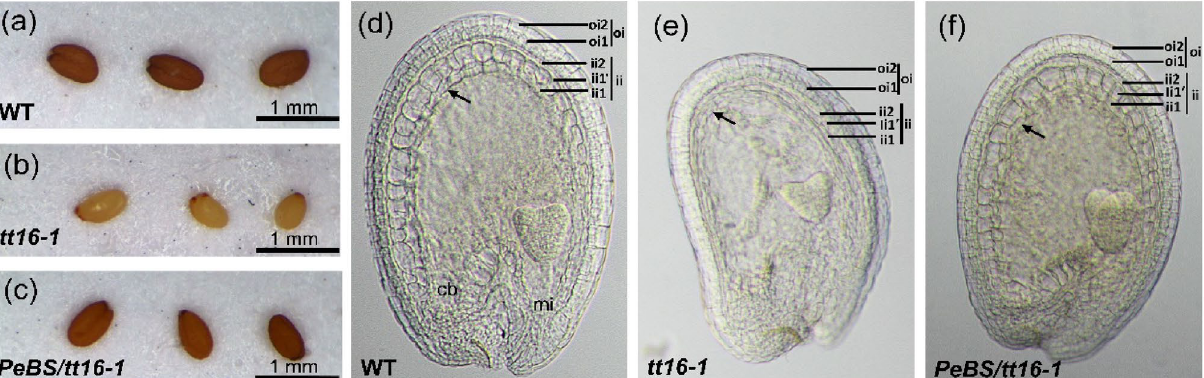
Figure 7. Phenotypes of seed pigmentation and structure of the seed coat. Seed pigmentation of mature seeds from wild-type (Col) ( a ), a tt16-1 mutant ( b ), and transgenic 35S::PeMADS28 in tt16-1 mutant plant ( c ). The development of seed coat from cleaned seed in wild-type (Col) ( a ), tt16-1 mutant ( b ), and transgenic 35S::PeMADS28 in tt16-1 mutant plant ( c ). The dark arrows are indicated the endothelium. cb, chalazal bulb; ii, inner integument; mi, micropyle; oi, outer